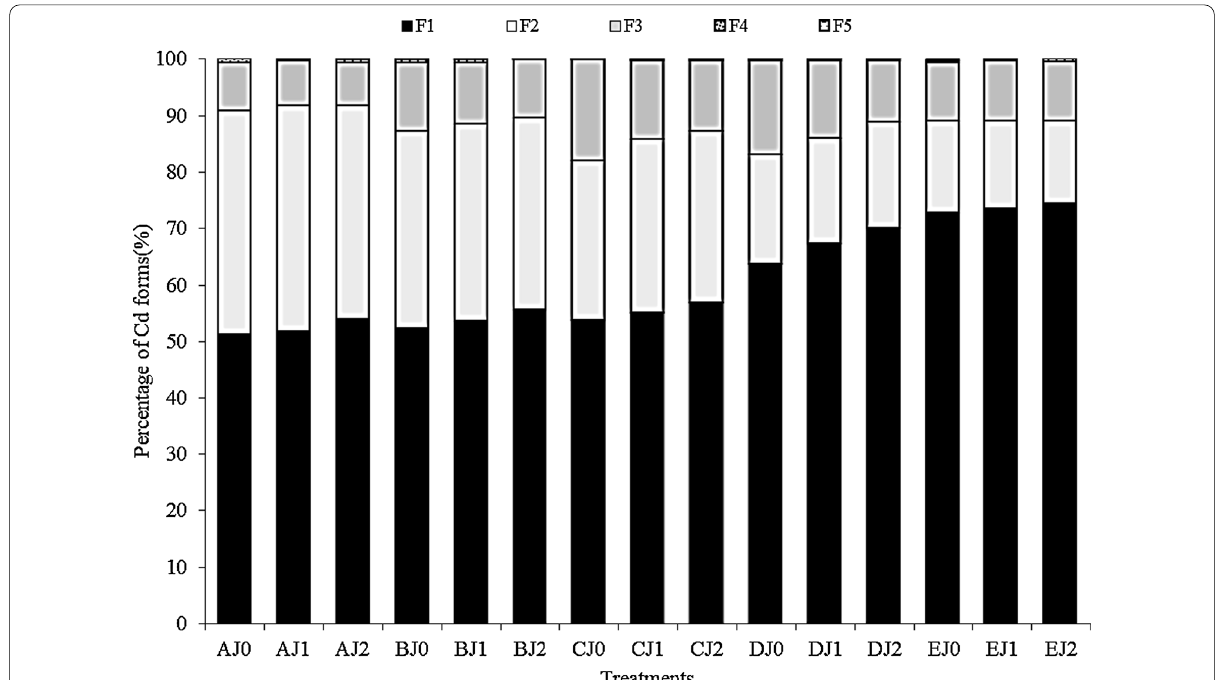
Fig. 2 Proportion of each form of Cd in rhizosphere soil after 60 days of planting in Sedum alfredii Hance. This figure represents the distribution of each form of Cd in the rhizosphere soil of Sedum alfredii Hance at harvest. AJ0 represents Cd7Pb 100 mg/kg, 0 mL of bacterial suspension; AJ1 represents Cd7Pb 100 mg/kg, 100 mL of bacterial suspension; AJ2 represents Cd7Pb 100 mg/kg, 200 mL of bacterial suspension. The rest is the same. F1, F2, F3, F4, F5 are different forms of Pb, exchangeable, bound to carbonates, bound to Fe–Mn oxides, bound to organic matter,